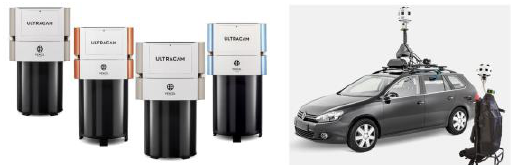
Fig. 1: UltraCam Aerial Sensor Family: UltraCamFalcon, UltraCam Condor, UltraCam Eagle and UltraCam Osprey (from left to right). With the Eagle we offer 4 different lens packages, the Osprey is available in two different versions. UltraCam Mustang and UltraCam Panther (on the right) are designed for terrestrial data acquisition.